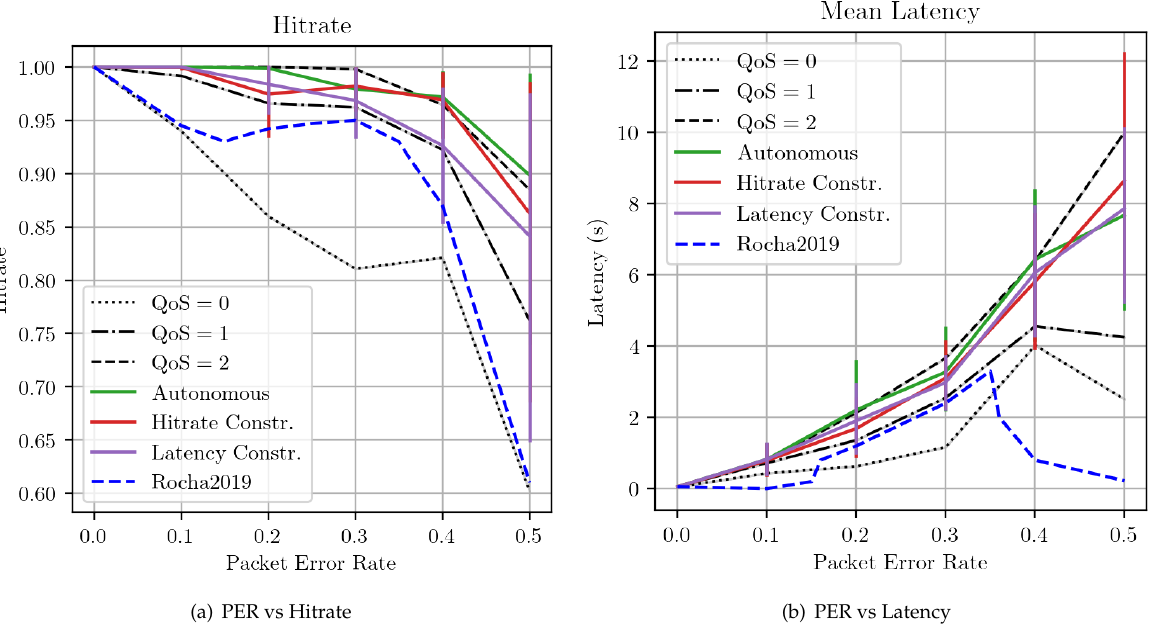
Figure 13. Average hitrate and latency for different scenarios with or without the proposed QoS con- troller. The method indicated as Rocha2020 refers to the work in